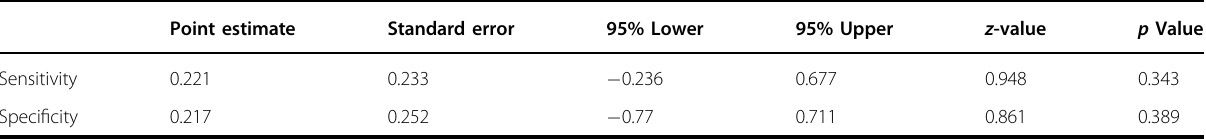
Table 3 Bivariate random-effect meta-regression z -scores for modality as